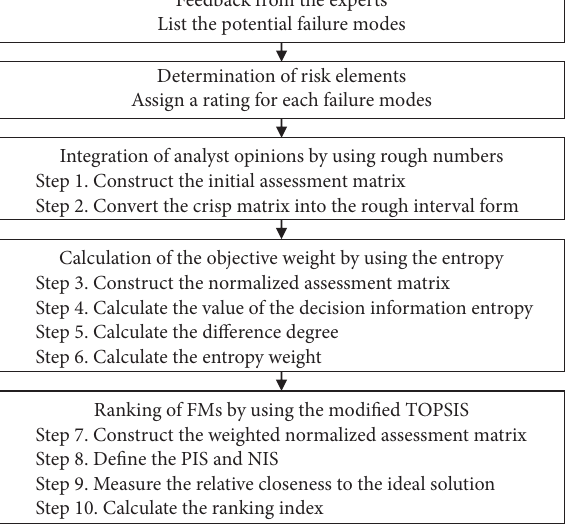
Figure 1: Analysis process of the proposed